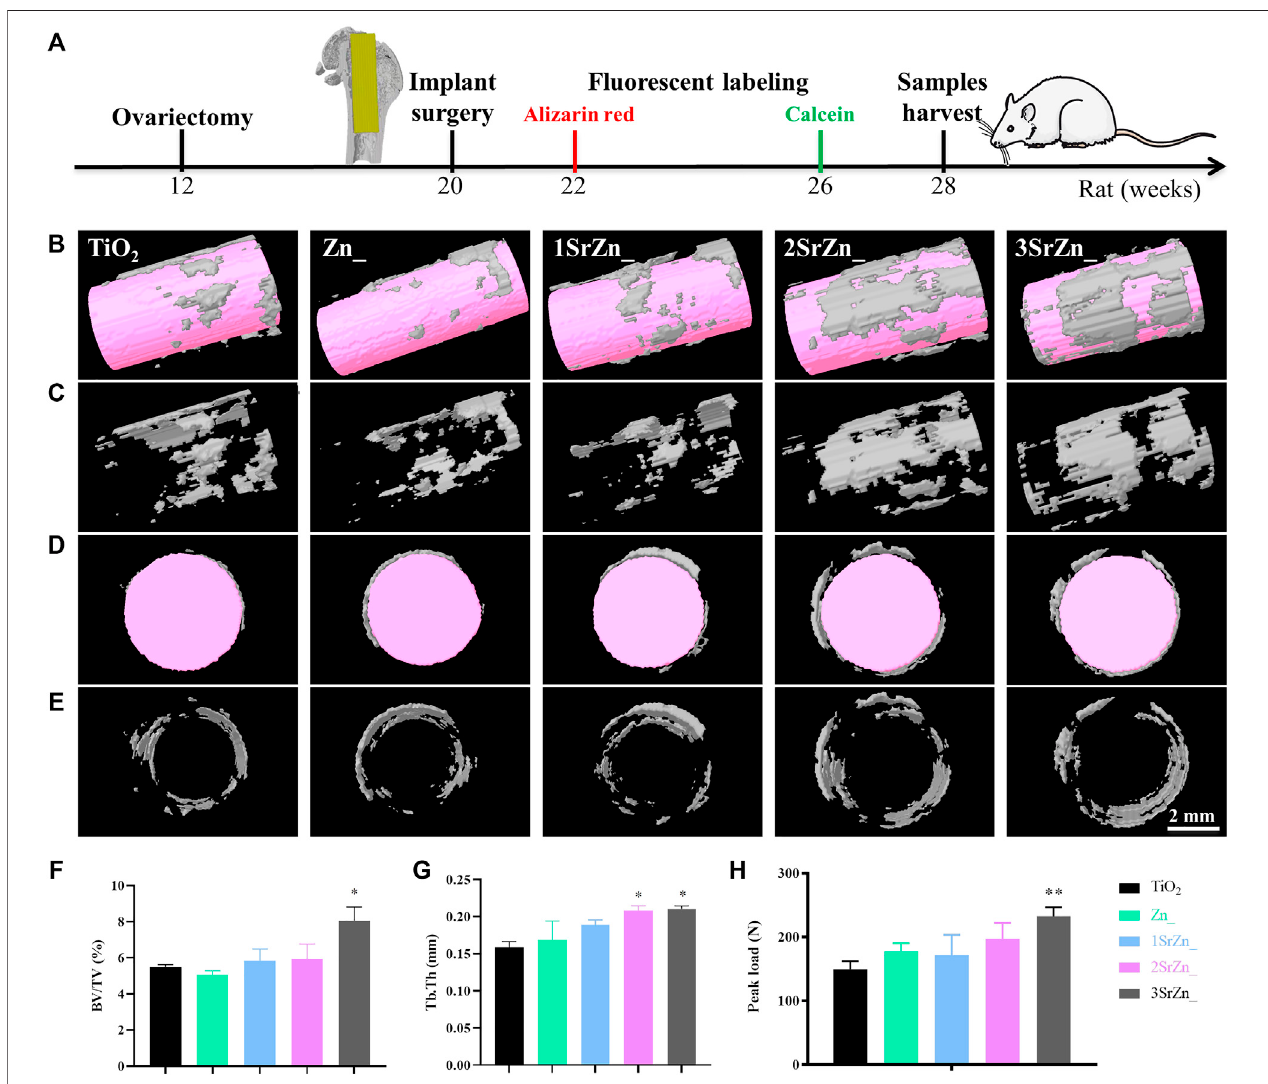
FIGURE 6 | Quality and quantity of regenerated bone tissue on Sr-Zn-augmented titanium surfaces in the OVX rat model. (A) The scheme of animal operation: the 12-week-old rat femoral model was constructed by ovariectomy, and at 20 weeks old, the implant surgery was conducted. At 2 and 6 weeks after implant surgery, the fl uorescentlabelingwasinjected.Thebonetissueandsampleswereharvestedat28 weeksold. (B-E) Reconstructed3Dmodelsofsurroundingbonesinmicro-CTwith inserted implants of longitudinal section with (B) or without implant (C) and of transverse section with (D) or without implant (E) . Quantitative analysis includes (F) BV/TV and (G) Tb. Th. (H) Peak load of the samples compared with the TiO 2 group.